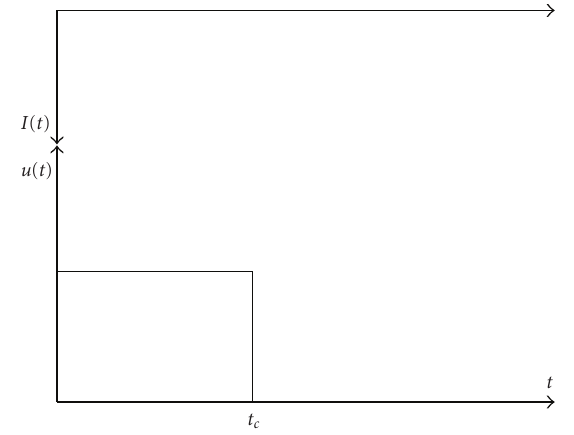
Figure 1: Impulse response function of a catchment.